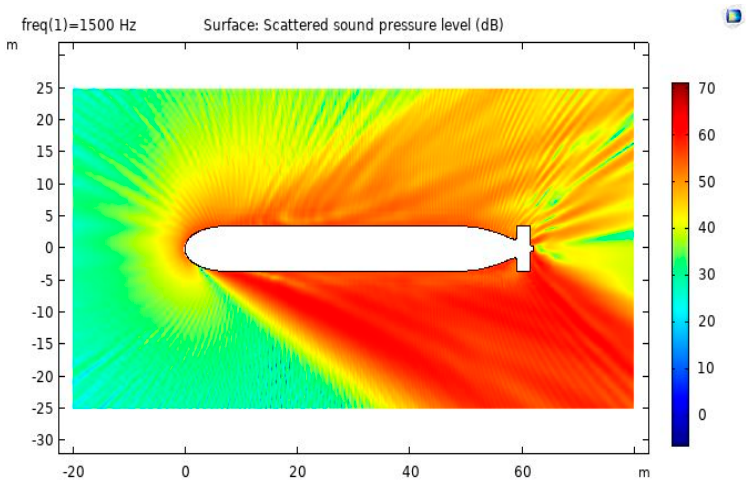
Figure 7. A cross-section at the level of scattered sound pressure .